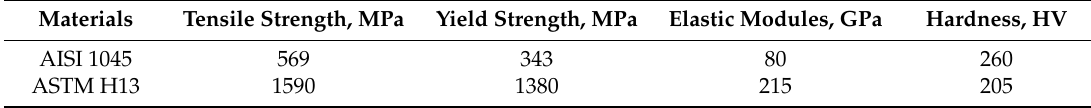
Table 2. Mechanical properties of AISI 1045 carbon and H13 tool